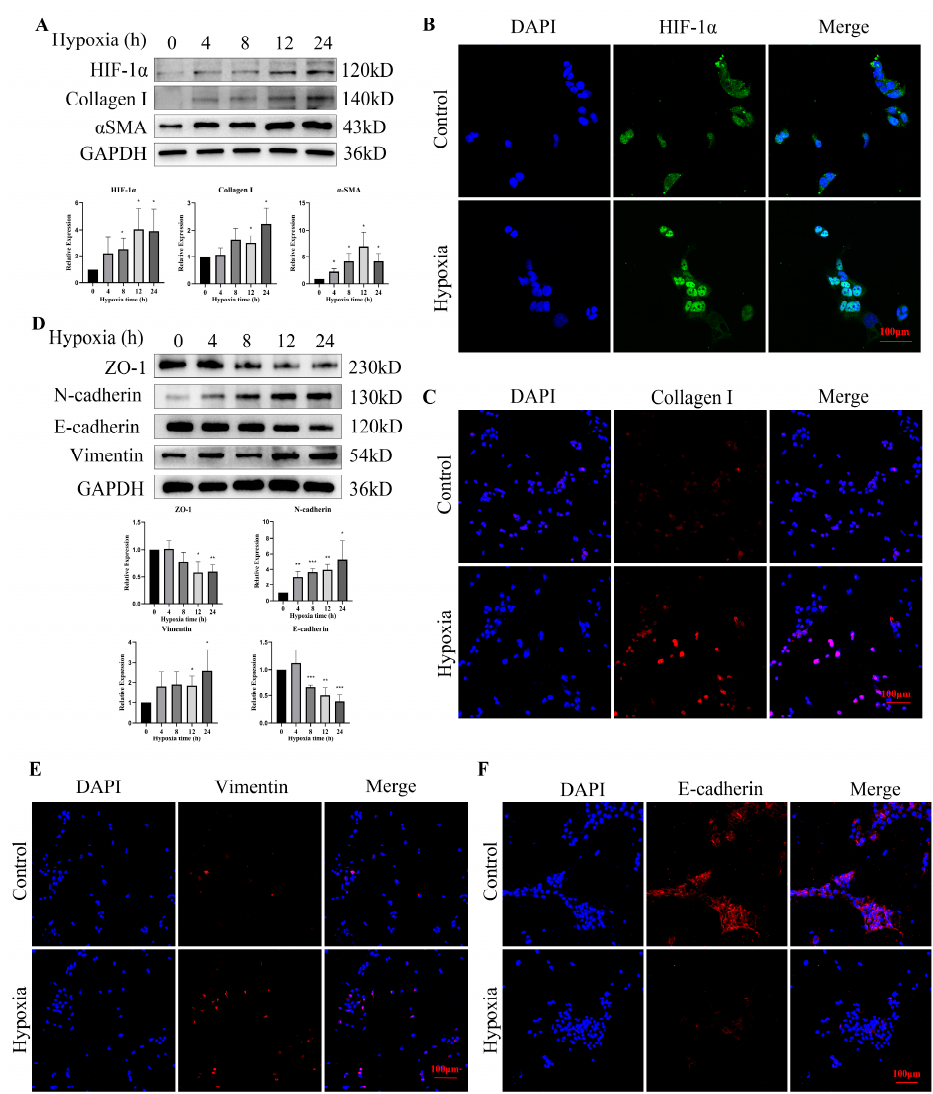
5 Figure 5. Hypoxic exposure induced the nuclear translocation of HIF-1 α in epithelial cells and promoted fibrosis- and EMT-related gene expression. ( A ) Western blotting of HIF-1 α , collagen I and α SMA after hypoxic exposure in epithelial cells. ( B ) Immunofluorescence of HIF-1 α after hypoxic exposure for 12 h. ( C ) Immunofluorescence of epithelial cells showed upregulation of collagen I after hypoxic exposure for 12 h. ( D ) Western blotting of EMT-related proteins after hypoxic exposure in epithelial cells. ( E ) Immunofluorescence of epithelial cells showed upregulation of Vimentin after hypoxic exposure for 12 h. ( F ) Immunofluorescence of epithelial cells showed downregulation of E-cadherin after hypoxic exposure for 12 h. Data are presented as the mean ± S.D. (n ≥ 3). * p < 0.05; ** p < 0.01; *** p < 0.001. Scale bars, 100 µ